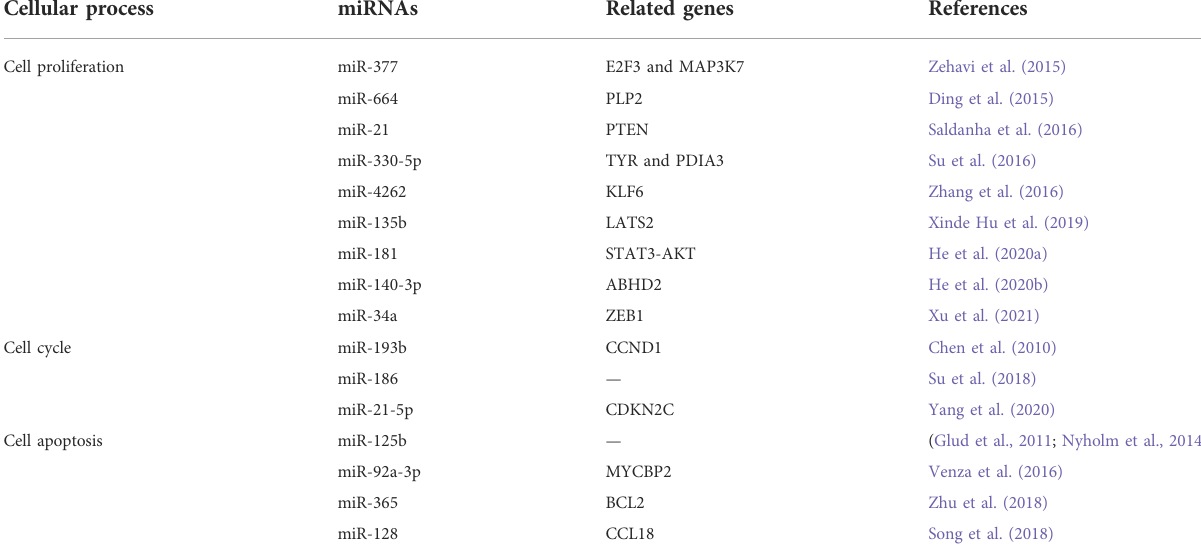
TABLE 4 Functional characterization of miRNAs in cell proliferation, cell cycle and apoptosis of melanoma.